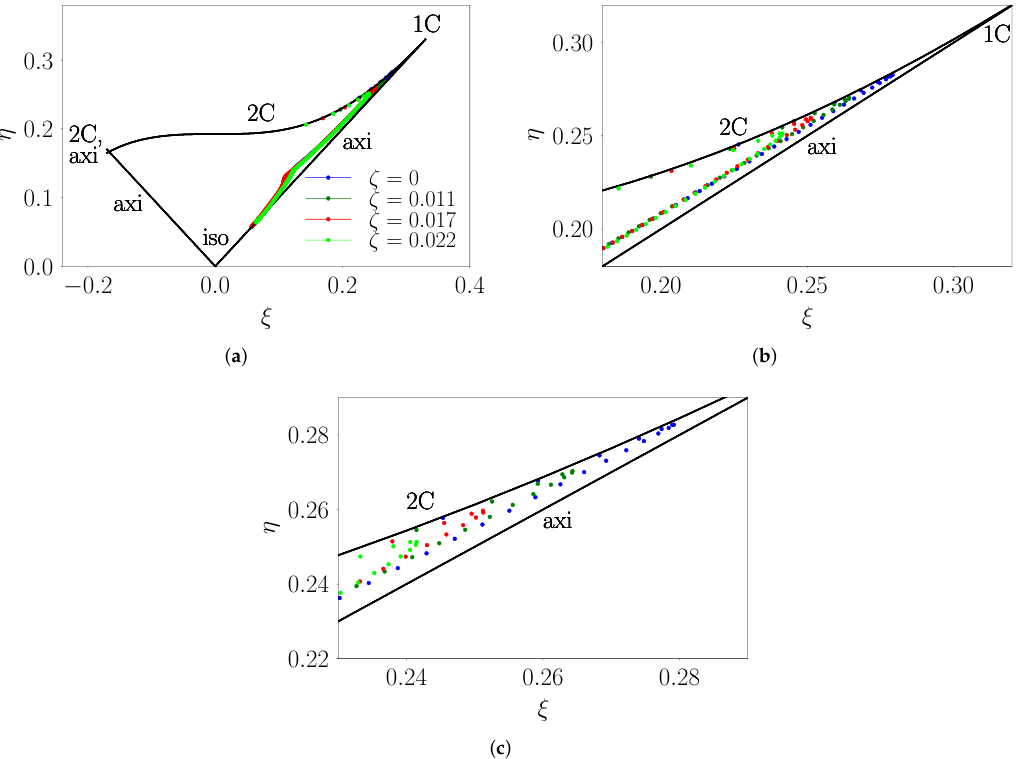
Figure 17. ( a ) Representation of the Reynolds stress structure in a Lumley triangle on the plane of invariants ξ and η of the Reynolds stress anisotropy tensor. Lines and vertices correspond to different states of turbulent stresses (i.e., iso, axi, 1C, and 2C represent isotropic, axisymmetric, one-component, and two-component states of turbulence, respectively). ( b ) Zoomed version ( a ) near the 1C corner; ( c ) even more zoomed to clearly illustrate the